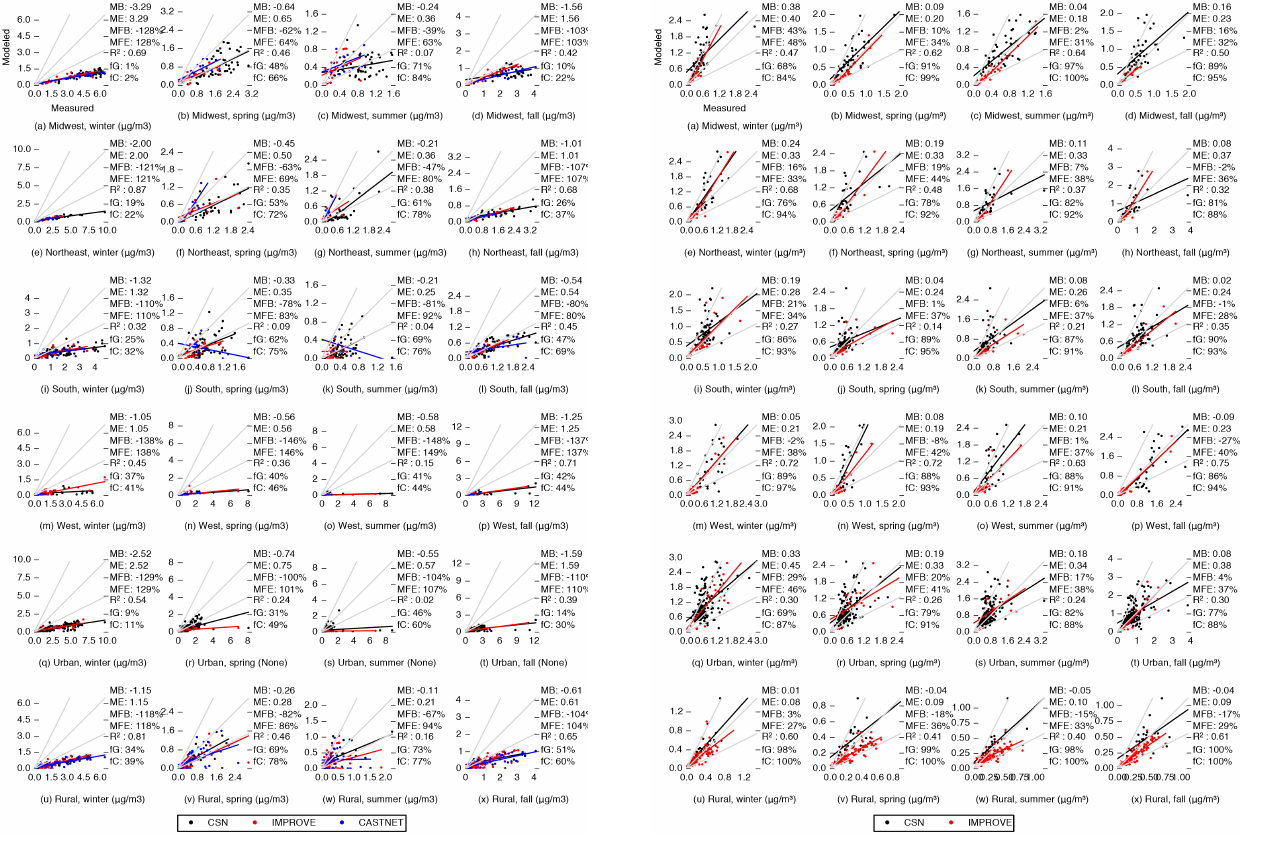
Figure 9. Comparison of modeled and measured particulate NO 3 concentrations, disaggregated by region and season.